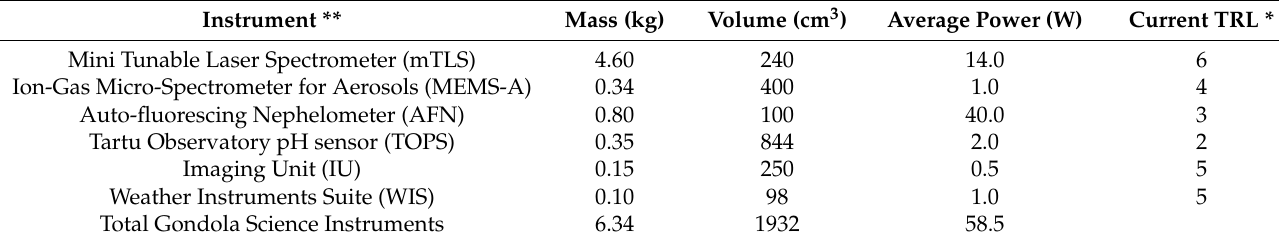
Table 1. Science instruments considered for the